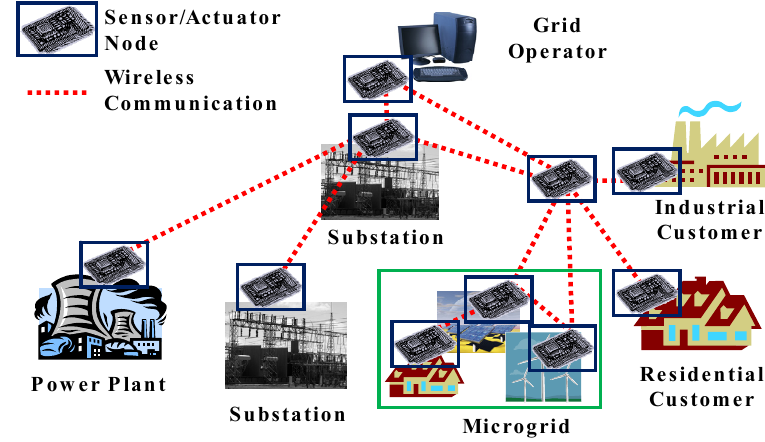
Figure 1. Example of a Smart Grid (SG) infrastructure including a Wireless Sensor and Actuator Network (WSAN).